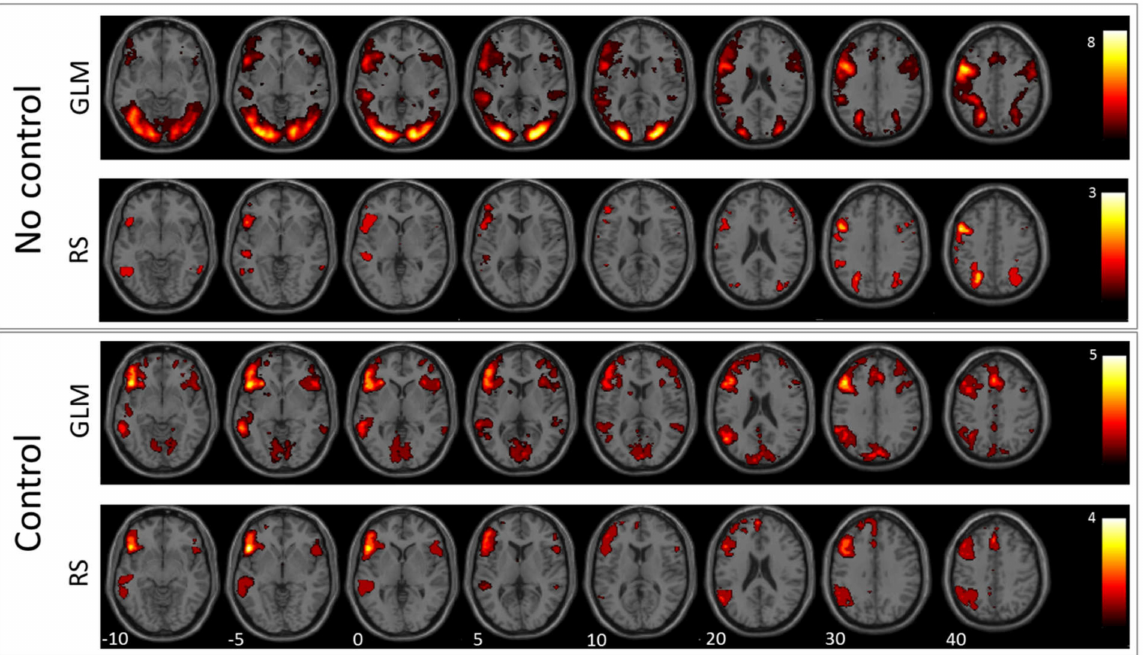
Figure 1. Verb generation: In this figure, the mean images of the used GLM contrast images and selected ICs for the verb generation task are shown. The first row depicts the GLM result without using the control condition and the second row the corresponding RS-fMRI result. The third row shows the mean of the selected language-related ICs when using the GLM contrast with the control condition as a template, and the fourth row shows the same for